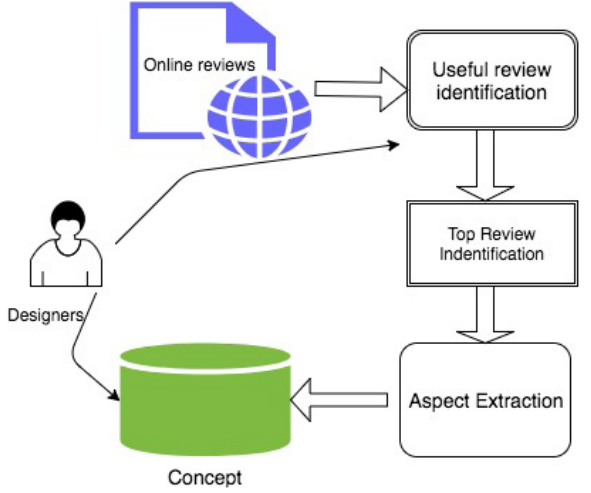
Fig. 3. The framework for analyzing online reviews on the Amazon shopping